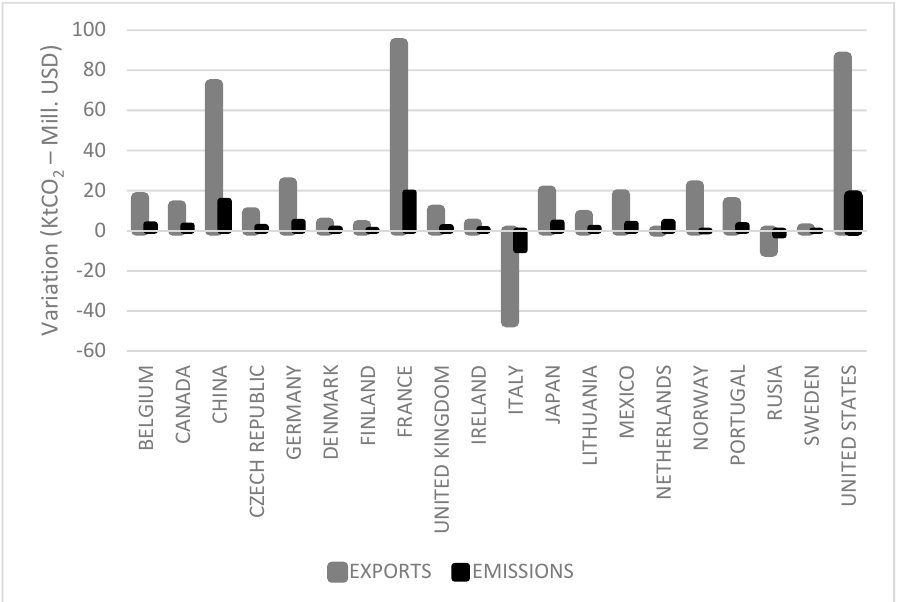
Figure 4. Variation of emissions (ktC0 2 ) and exports (Mill. USD) (2011–2016).